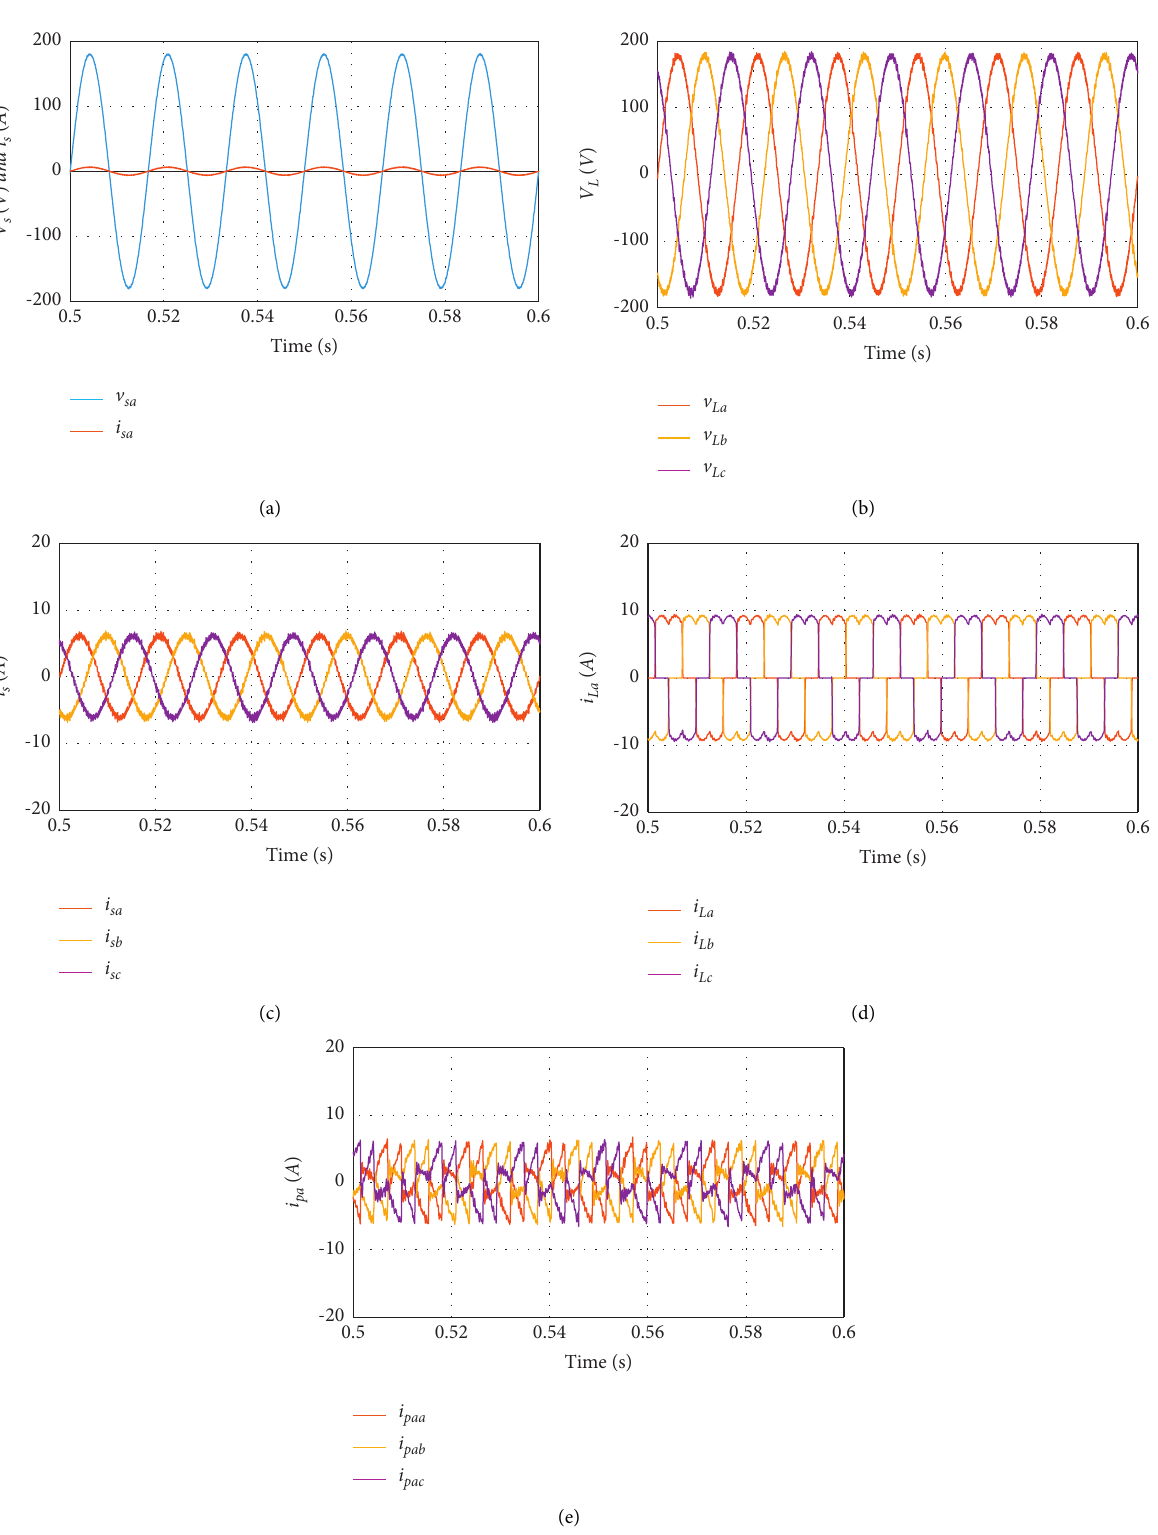
< P L . (a) Grid voltage and wind − pv